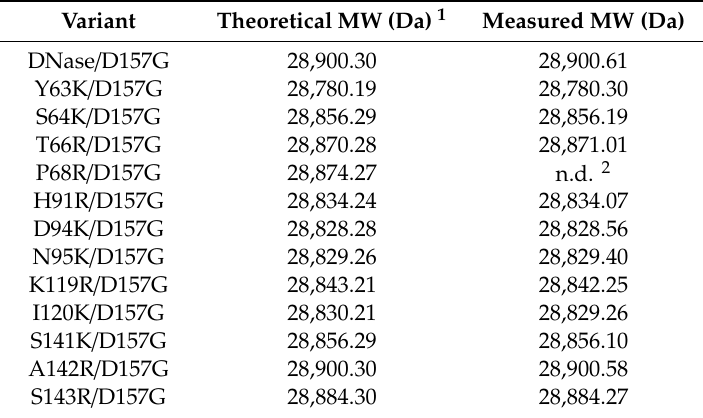
Table 1. Molecular masses of nuclease variants.